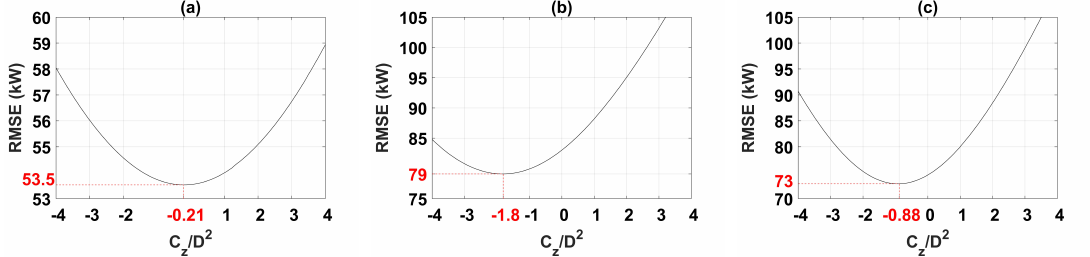
Figure 13. The effect of C z on RMSE of power prediction showing optimum values for: ( a ) stable regime, ( b ) neutral regime, ( c ) unstable regime, normalized by D 2 , where D is the diameter of the wind